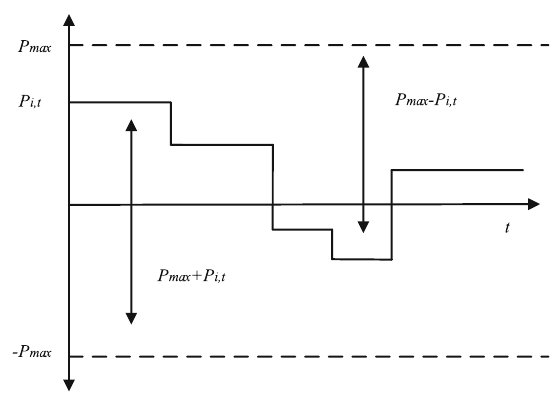
Fig. 6 Available capacity of an EV for